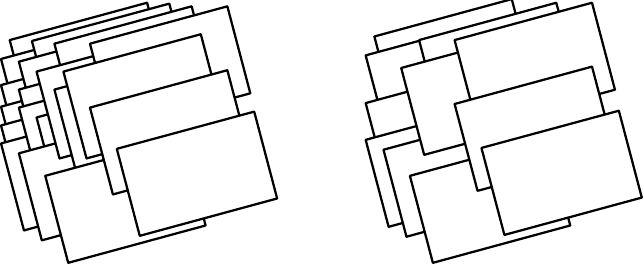
Figure 2. Images with excessive overlap (e.g., left ) are not used to create the final result.